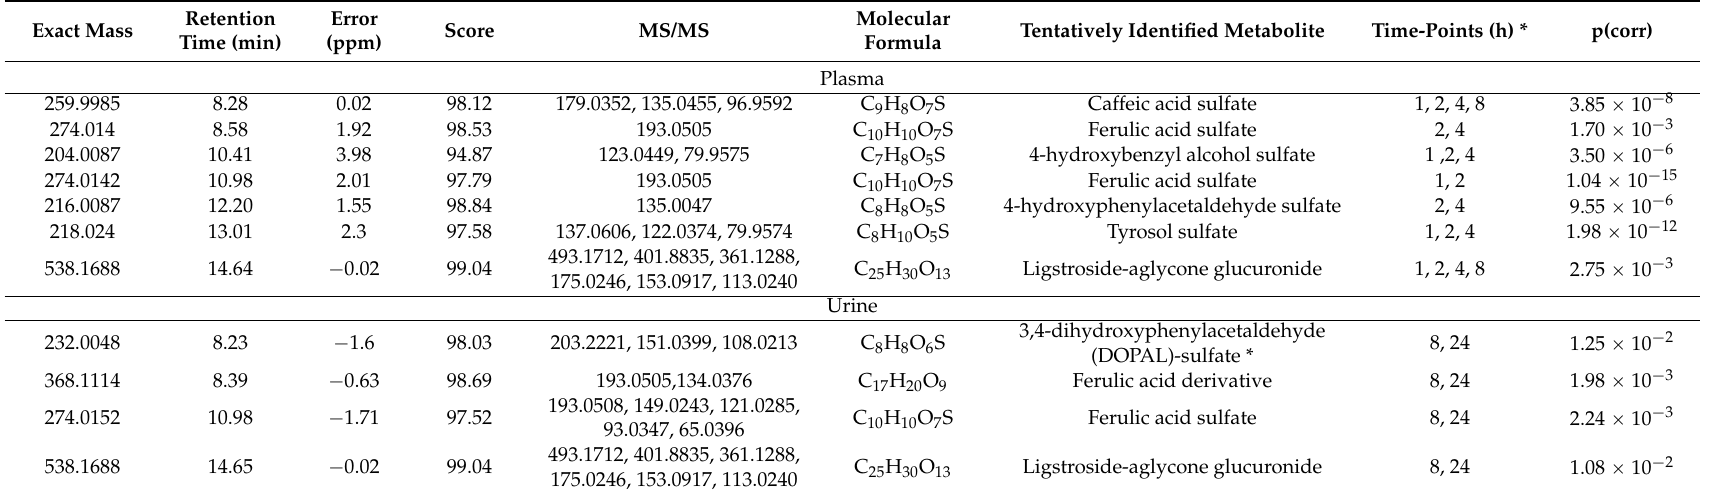
Table 3. Metabolites significantly increased in the plasma and urine samples of the volunteers following the intake of Fraxinus extract and related to the family of phenolic compounds: untargeted